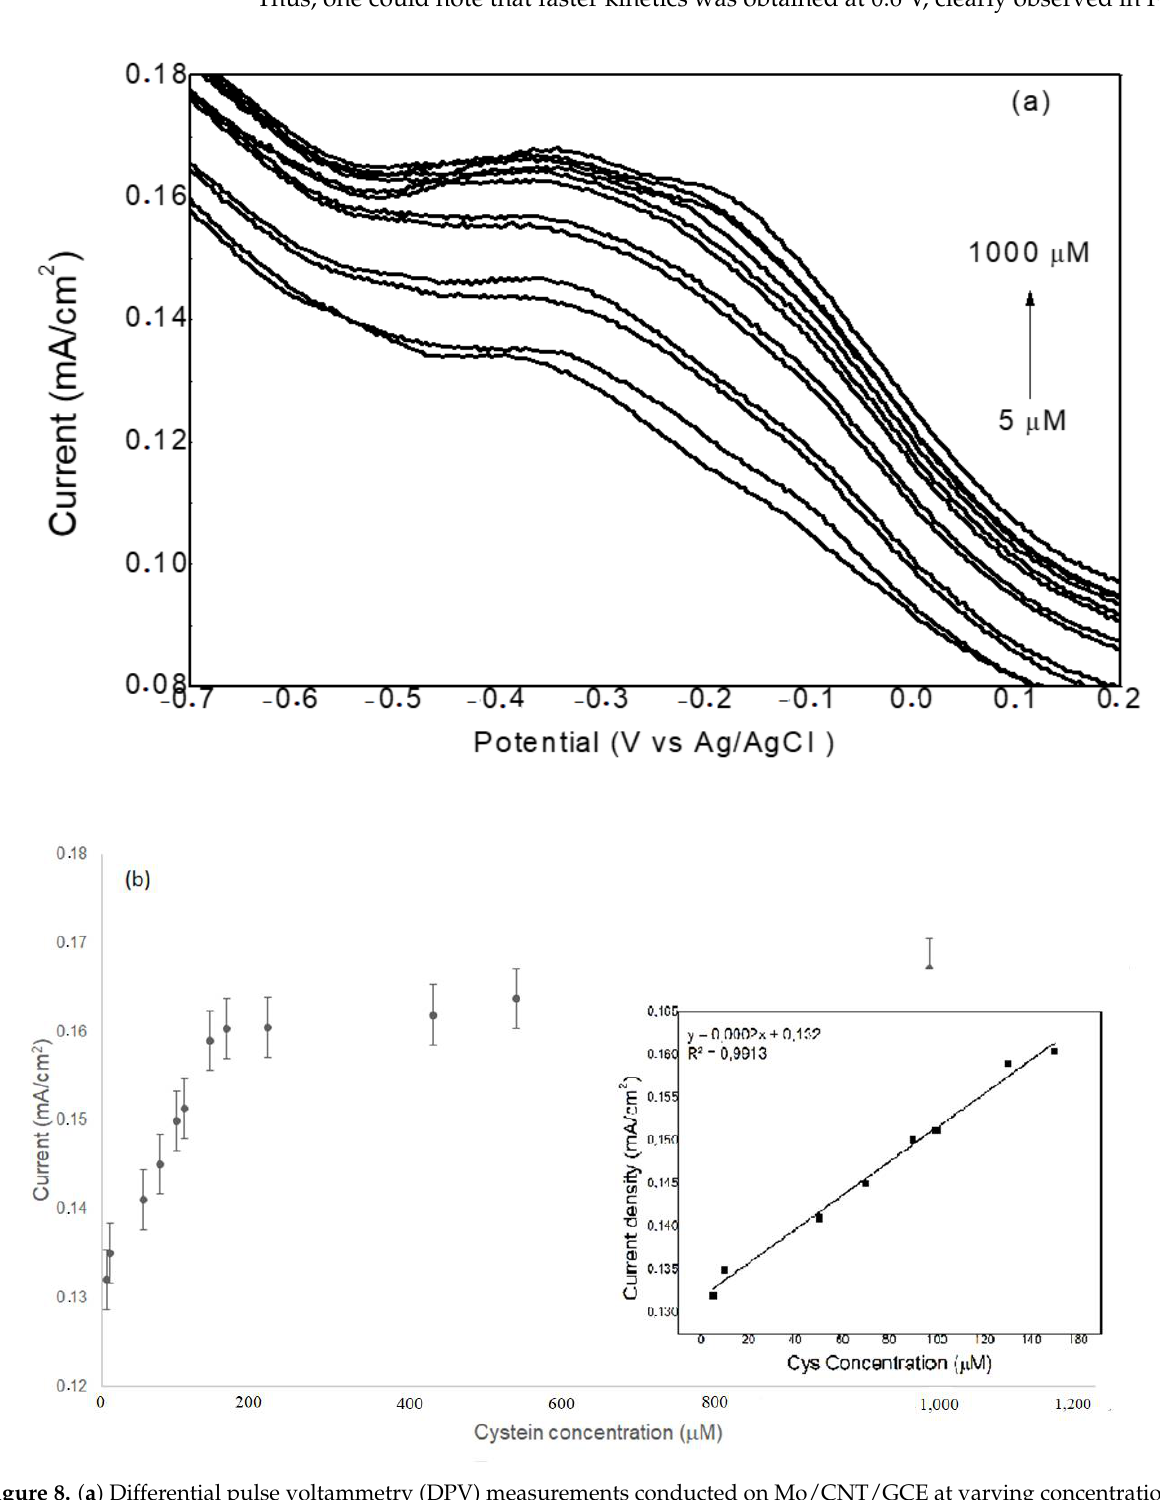
Figure 8. ( a ) Differential pulse voltammetry (DPV) measurements conducted on Mo/CNT/GCE at varying concentrations (0–1000 µM L-C) in 0.1M PBS; ( b ) calibration plot obtained from maximum current density vs. L-C concentration. Following, sensitivity measurements by DPV, limit of blank (LOB), the lowest detec- tion limit (LOD) and limit of quantification (LOQ) were determined for the Mo/CNT/GCE L-C electrochemical sensor. First of all, LOB was determined by measuring the blank elec- trode’s response and standard deviation of 10 blank electrode responses. LOD was found as 0.25 µM and LOQ was also found as 0.75 µM with S/N = 3 signal to noise ratio.